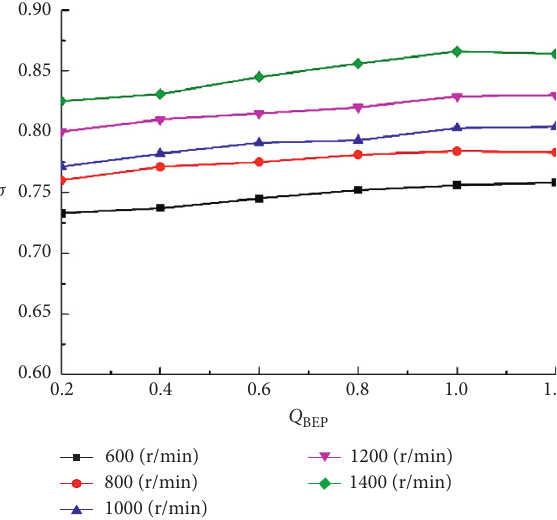
Figure 5: Experimental results of slip